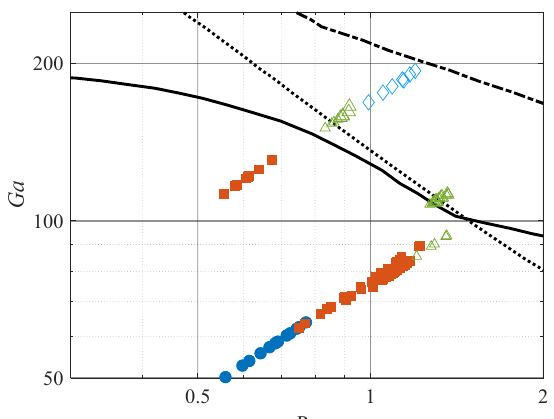
Figure 4. Phase diagram of a single bubble’s behavior (Cano–Lozano et al., 2016) and a pair of bubbles’ behaviors in the ( Ga , Bo ) plane. Solid line: critical curve for zigzag transition of a single bubble. Dotted line: critical curve for the standing eddy emerging via axisymmetric simulation. ● : M1. ■ : M2. △ : M3. ♢ : M4.